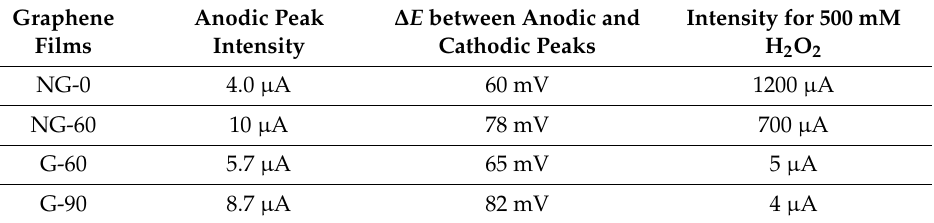
Figure 2. Cyclic voltammetry on ( a ) NG-0; ( b ) NG-60; ( c ) G-60 and ( d ) G-90 films, in a 0.5 M Table 2. Results of electrochemical measurements on NG and pure graphene